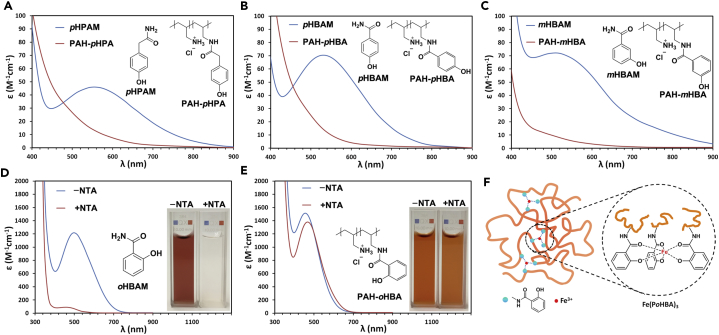
Weak Monodentate Ligands on Polymer Chains Cannot Induce Conformational Stability Effect(A) Comparison of visible spectra of ferric pHPAM and PAH-pHPA systems. Condition: 1 mM Fe3+, 4 mM ligands in 0.1 M KCl solution at pH 2.6.(B) Comparison of visible spectra of ferric pHBAM and PAH-pHBA systems. Condition: 1 mM Fe3+, 4 mM ligands in 0.1 M KCl solution at pH 2.6.(C) Comparison of visible spectra of ferric mHBAM and PAH-mHBA systems. Condition: 1 mM Fe3+, 4 mM ligands in 0.1 M KCl solution at pH 2.6.(D) Visible spectra of ferric oHBAM system with the competition of NTA. Condition: 1 mM Fe3+, 4 mM ligand, and 1 mM NTA in 0.1 M KCl solution at pH 4.0.(E) Visible spectra of ferric PAH-oHBA system with the competition of NTA. Condition: 1 mM Fe3+, 4 mM ligand, and 1 mM NTA in 0.1 M KCl solution at pH 4.0.(F) Schematic illustration of ferric coordination with PAH-oHBA.